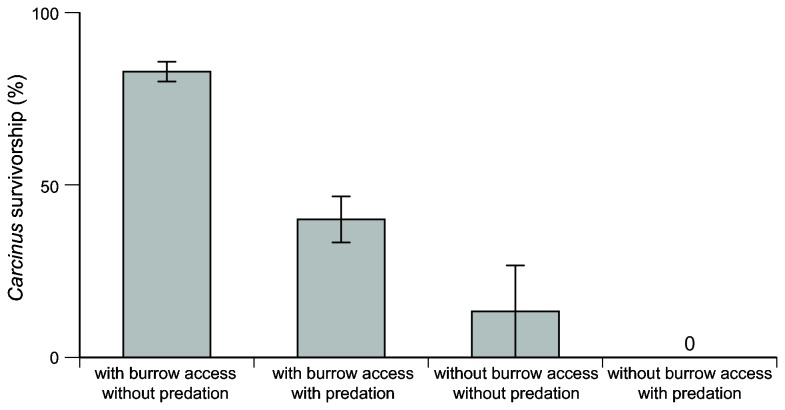
Differential Carcinus survivorship with and without burrows access and predation exposure.Tethered Carcinus with access to burrows to avoid desiccation and in cages to avoid predation experienced the highest survivorship, while those exposed to both stressors experienced significant mortality. These results underscore the role of Sesarma burrows as refuges from desiccation, which transform inhospitable die-off banks into benign intertidal habitats capable of sustaining large, burrow-dwelling Carcinus populations.